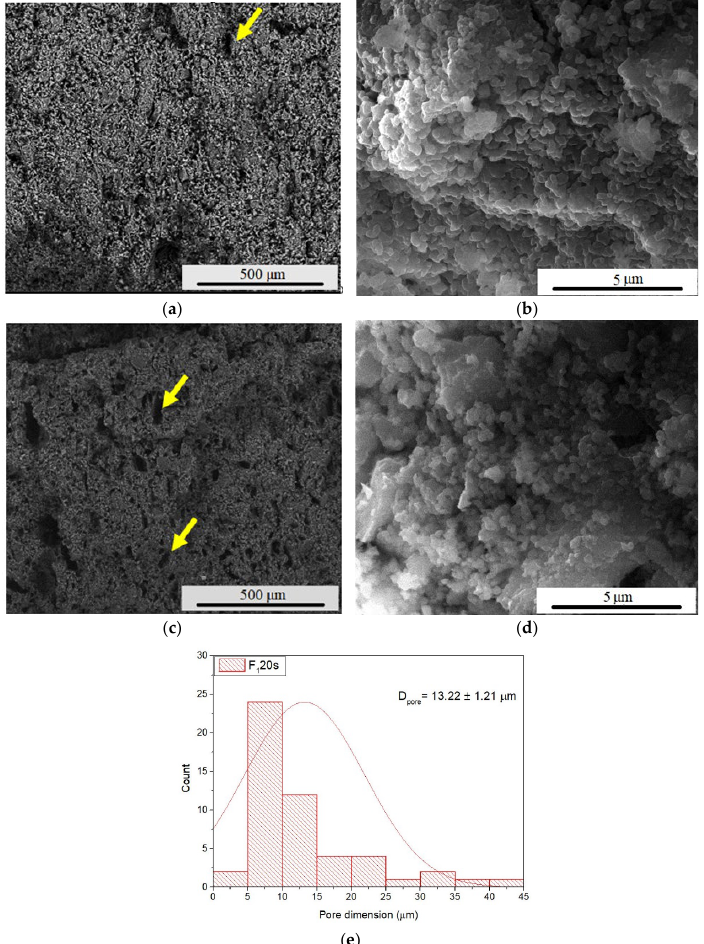
Figure 3. SEM images magnification ×200 and ×20,000 of F 1 ( a , b ) and F 1 20s ( c , d ) samples and pore dimension distribution ( e ); the pores are indicated with yellow arrows. When sintering forsterite ceramic bodies (sample F 1 ) at 1250 °C, the presence of pores is visible (yellow arrow), but they are in a relatively small number. When forsterite pow- der was mixed with a porogenic agent of 20% wt., a higher number of pores with average dimensions of 13.22 µ m was found (sample F 1 20s—see Figure 3e). Figure 4 exhibits the EDS (X-ray energy dispersion) spectra of the F 1 and F 1 20s sam- ples. It can be seen that, in both cases, the specific elements of forsterite (Mg, Si, O) were identified, once again confirming that the elements present in the porogenic agent did not remain in the sample composition, influencing only its porosity.